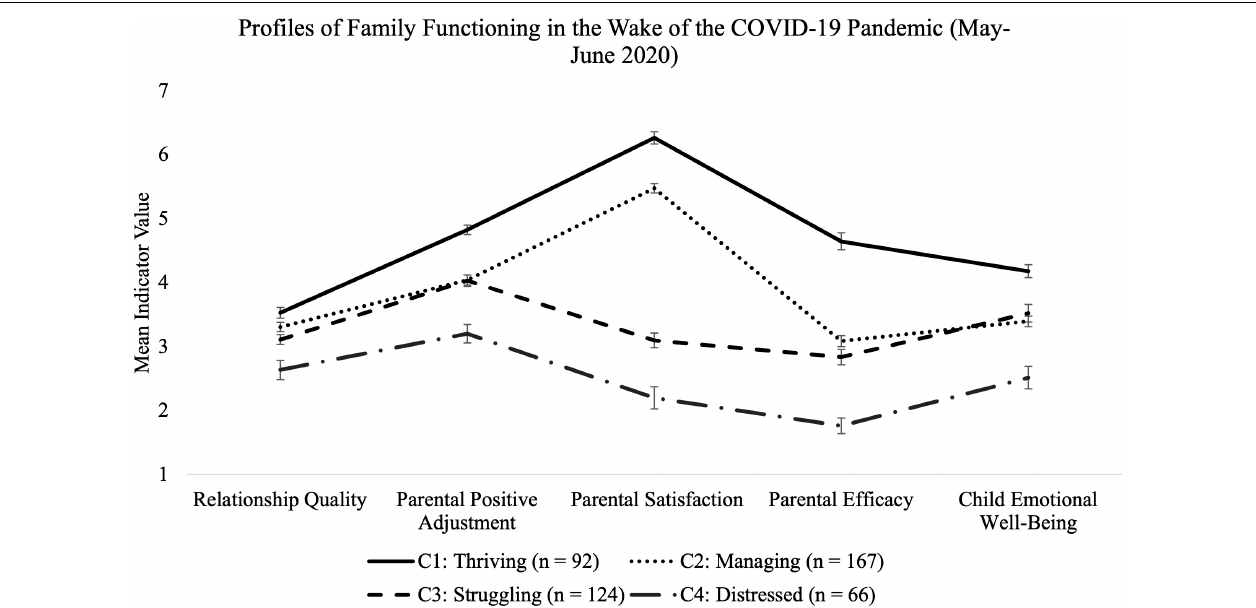
FIGURE 2 | Plot comparisons of estimated means and standard errors of four different family functioning profiles during the early stages of the COVID-19 pandemic (May–June 2012). High values indicates more positive outcomes for all family thriving indicators. A 4-class solution was determined to be the best-fitting solution with profiles identified in the plot key.